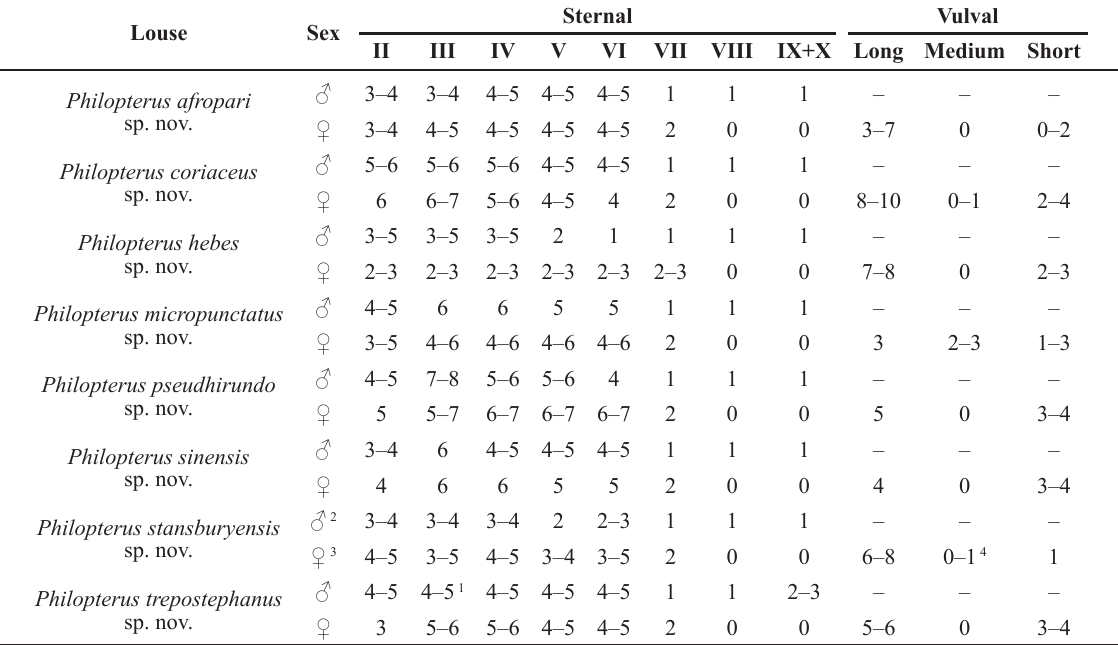
Table 3. Abdominal and vulval chaetotaxy of the species of Philopterus Nitzsch, 1818 described in this paper. Only sternal setae are listed here; for tergal setae, see Table 2; for pleural setae, see Table 4. Numbers denote the numbers of setae on one side of the abdomen only; for setal counts in the entire setal row of each segment, these numbers thus need to be